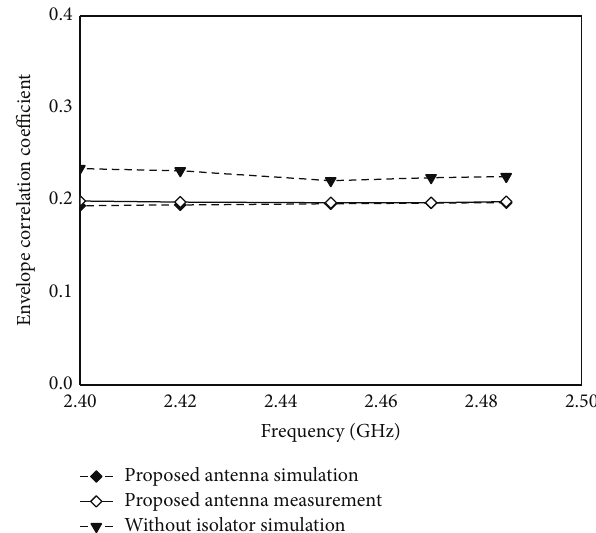
Figure 12: Simulated and measured envelope correlation coefficients of the proposed antenna with and without isolator.